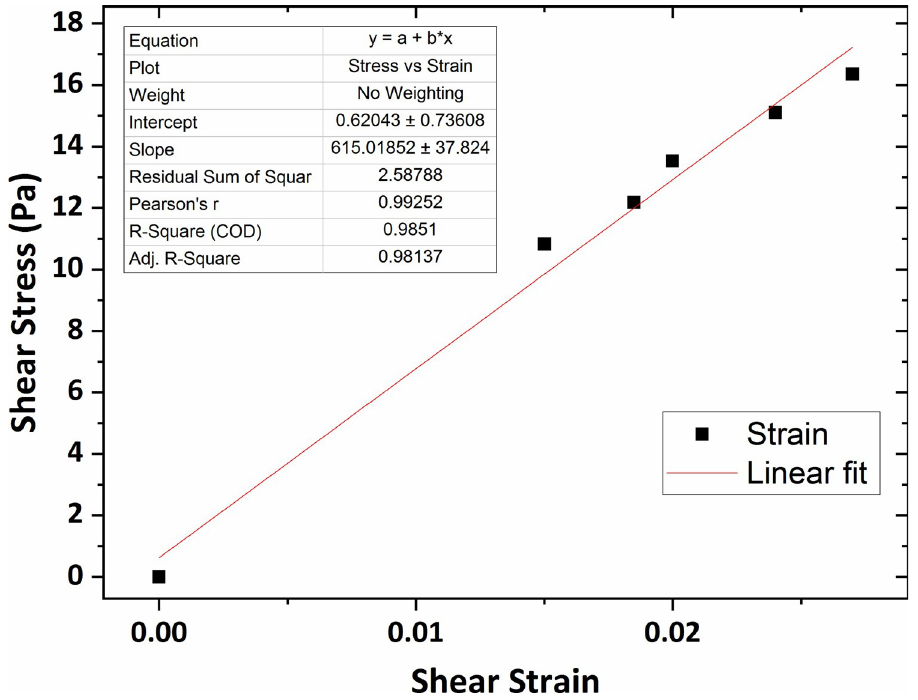
Fig 11. The graph of shear stress versus shear strain for the agarose gel of 0.6 wt % percent concentration.